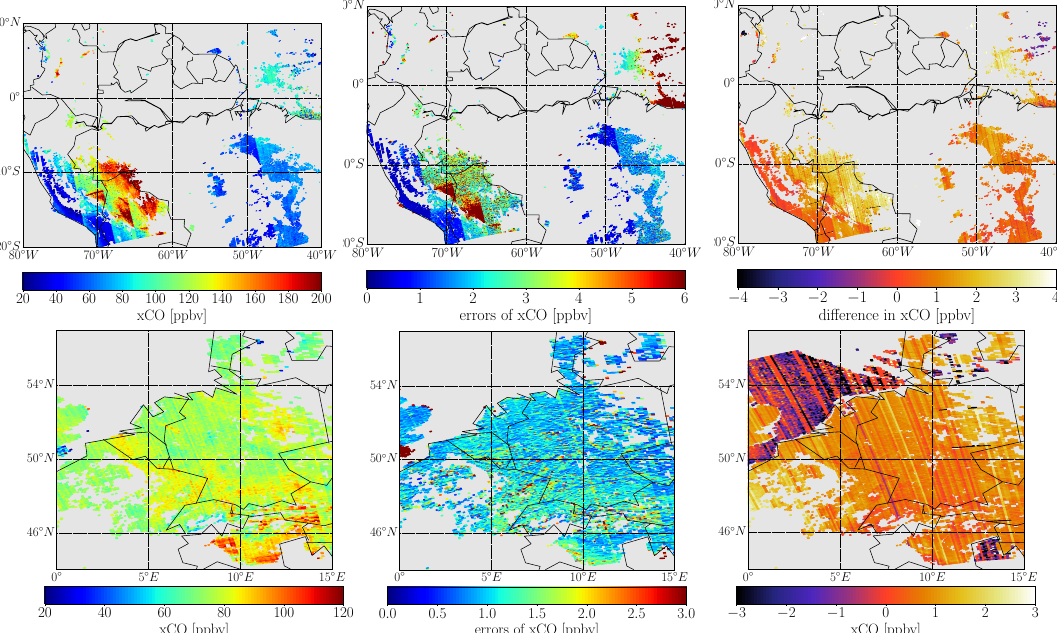
Figure 16. CO mole fractions (left column) and errors (center column) for SDRM-based retrievals, along with differences between SDRM and H16 (SDRM-H16) over Amazonia (top-row) and Central-Europe